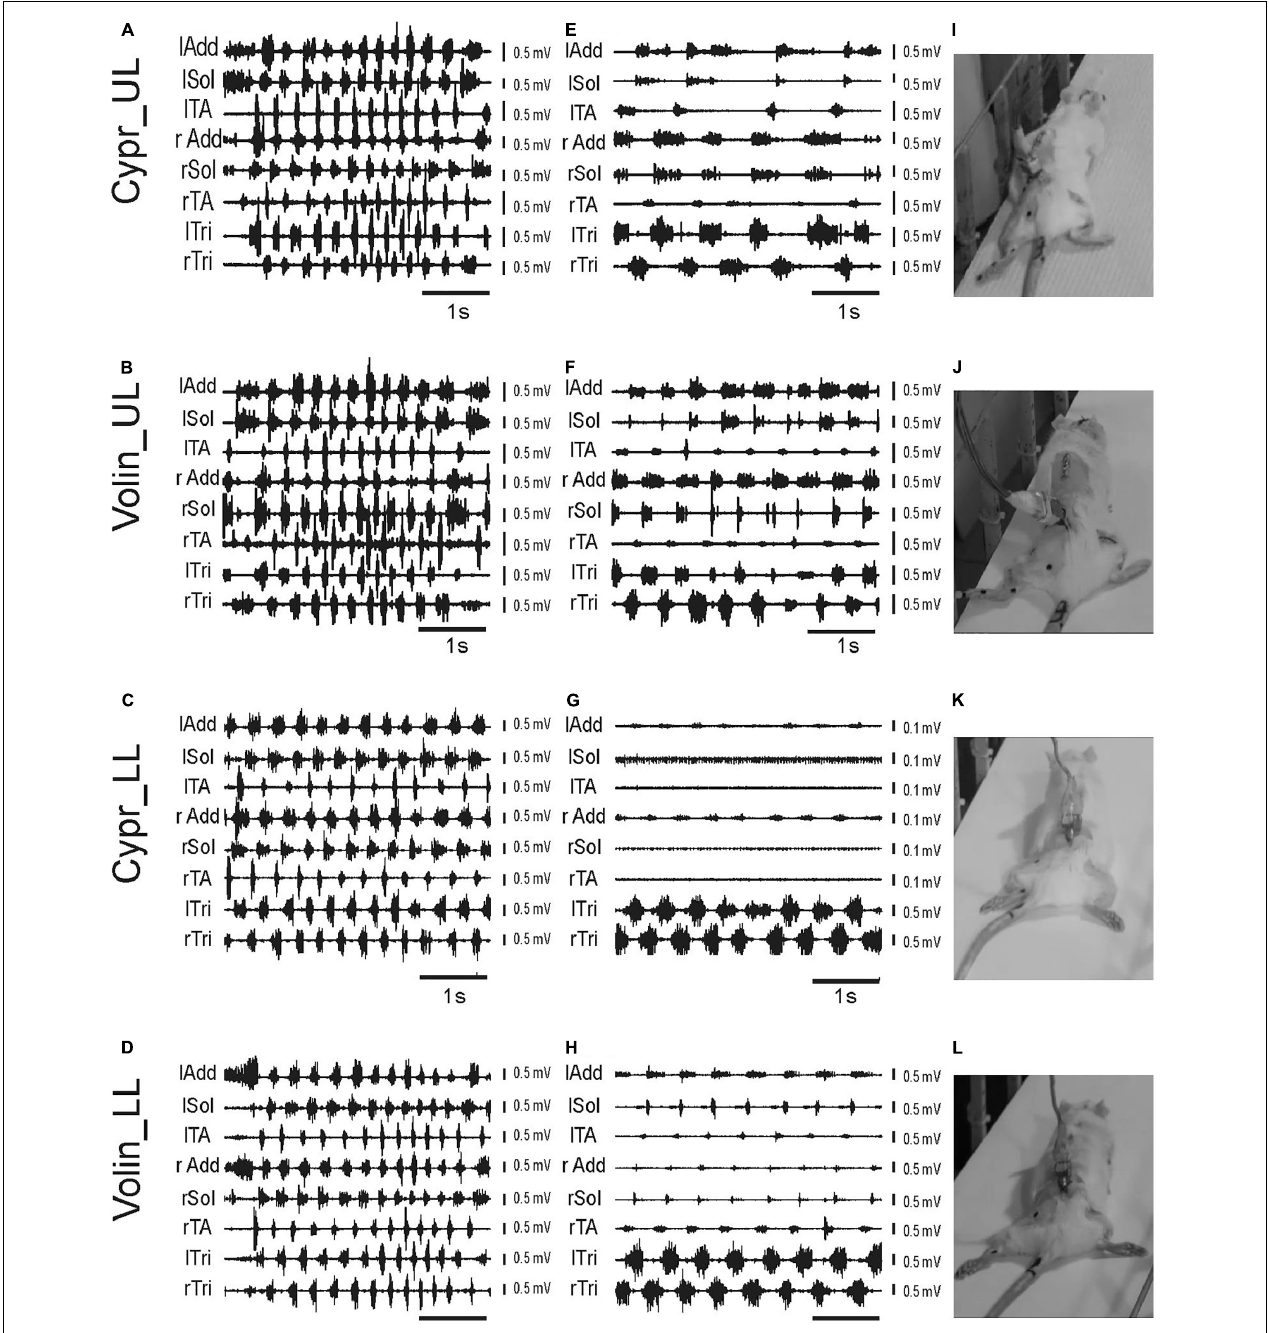
FIGURE 2 | Examples of EMG recordings illustrating hindlimb locomotor impairments in adult freely moving rats induced by blockage of various 5-HT receptors after IT application of either Cyproheptadine (Cypr; A,E,I,C,G,K ) or Volinanserin (Volin; B,F,J,D,H,L ) in the upper lumbar (UL) or low lumbar (LL) spinal cord. Left panels (A–D) present examples of typical EMG bursts recorded during voluntary locomotion along the horizontal runway in adult freely moving rats in the control pre-drug situation. Middle panels (E–H) present examples of EMG activity recorded 3–5 min after the drug administration when usually the highest deterioration of locomotor performance was obtained. Note that 3–5 min after either drug administration (E–H) the hindlimb EMG was greatly reduced in amplitude and frequency in all cases. We took care to analyze 8 – 10 rhythmic cycles from the period of highest deterioration (just prior to total paralysis in the case of Cypr treatment in LL rat). All the rats lost hindlimb body weight support and plantar stepping abilities after blockade of 5-HT 2A receptors. The increase in EMG amplitude of forelimb muscles (lTri and rTri) reflects the increased use of the forelimbs for progression. See that in LL rats after Cypr application the rhythmic EMG activity of Sol and TA disappeared completely (G) , Right panel (I–L) presents the individual frames illustrating hindlimb paralysis observed after IT drug applications (see video material presented in Supplementary Information attached to the paper). lAdd/rAdd, left/right adductor muscle; lSol/rSol, left/right soleus muscle; lTA/rTA, left/right tibialis anterior muscle; lTri/rTri, left/right triceps brachii muscle; Cypr, Cyproheptadine; Volin, Volinanserin; UL, upper lumbar segments (L2/L3); LL, low lumbar spinal cord (L5/L6).